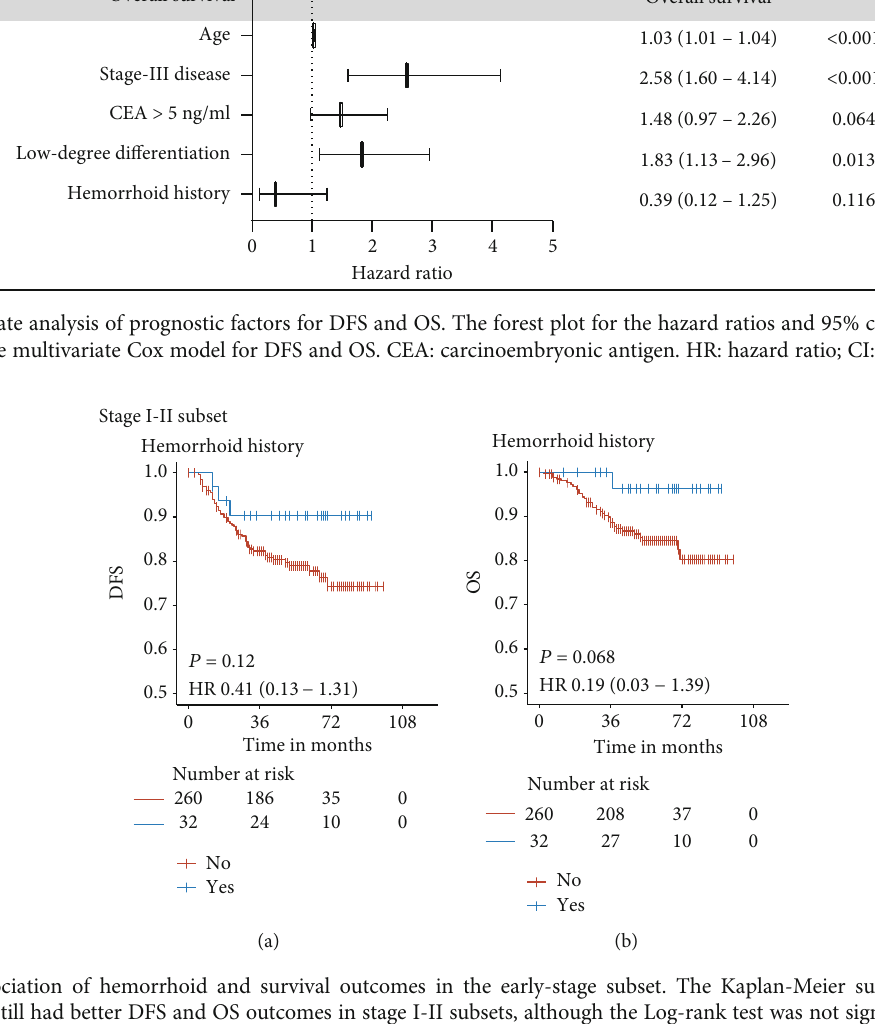
Figure 4: The association of hemorrhoid and survival outcomes in the early-stage subset. The Kaplan-Meier survival curves showed hemorrhoid group still had better DFS and OS outcomes in stage I-II subsets, although the Log-rank test was not signi fi cant. DFS: disease- free survival; OS: overall